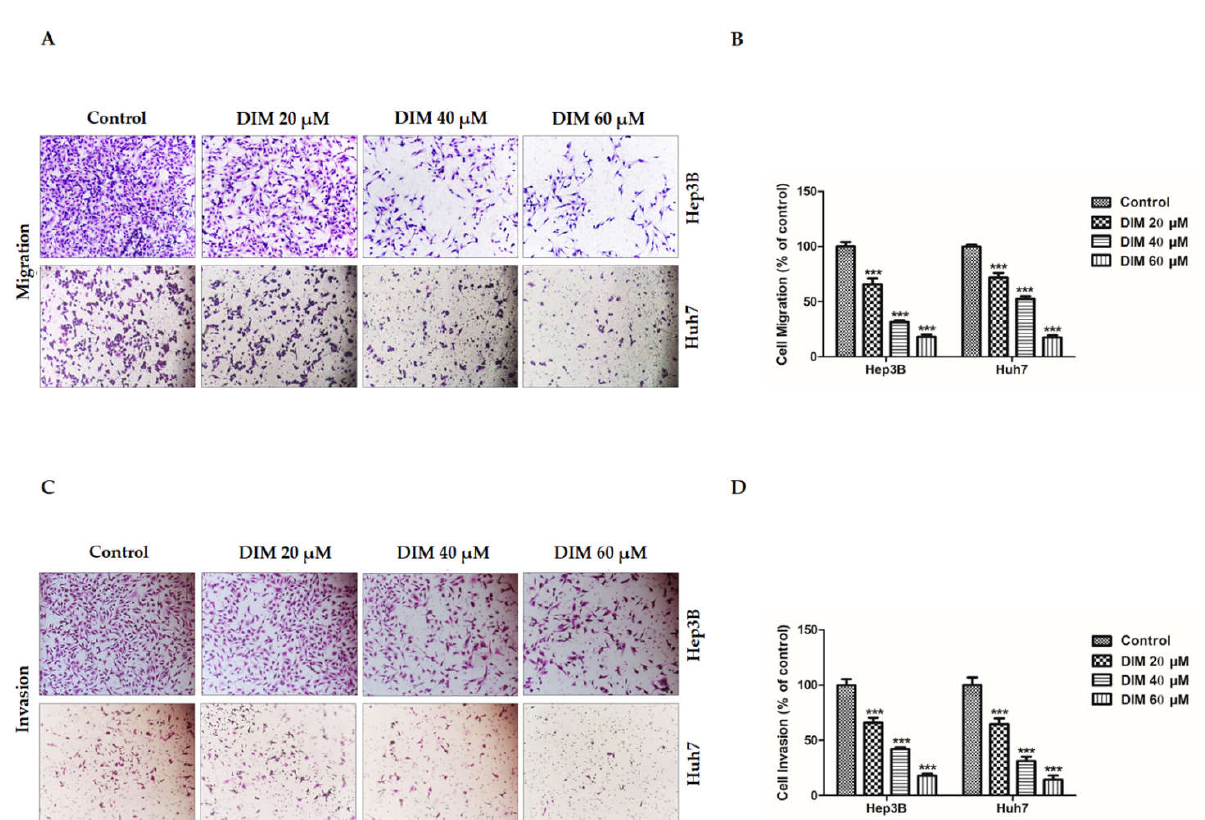
Figure 6. DIM inhibits the migratory and invasive ability of HCC cell lines. ( A , C ) Determination of anti-cancer effects of DIM on the migratory and invasive ability of Hep3B and Huh7 cells examined by transwell assays after 24 h treatment with DIM under a phase-contrast microscope at a magnification of ×200. ( B , D ) Bar graphs showing the relative assessment ( % ) of numbers of migrated and invaded cells (per unit area) compared to the controls. Data are presented as mean ± SE of three independent experiments. ***, p < 0.001 denotes significant variation compared to the control group.